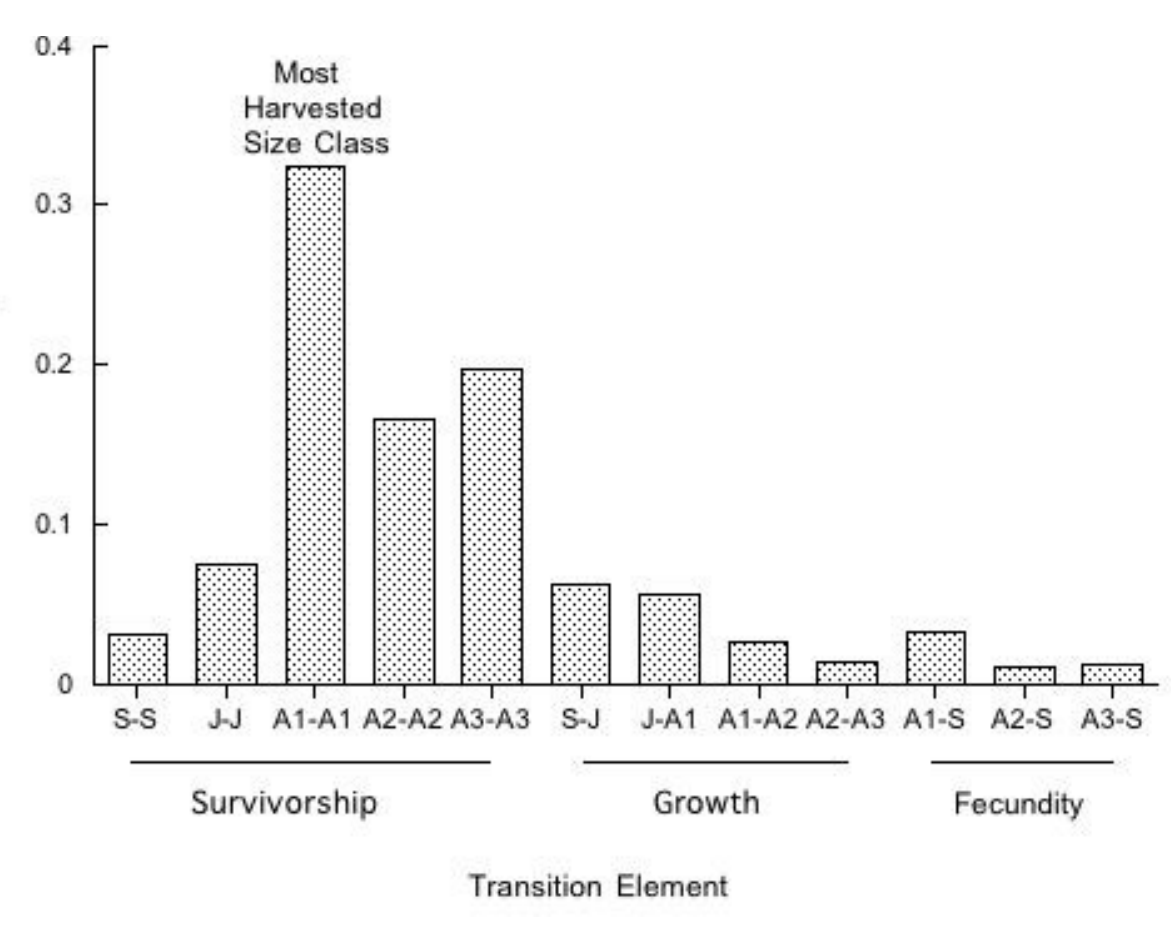
Fig. 4. Elasticity values for transition elements, or the relative contribution of each transition element to l , the finite population growth rate at stability. Because the elasticities of l to all of the elements in a matrix sum to 100%, the elasticity of l to a given element may be interpreted as the relative importance of that element to l . The transition elements are on the horizontal axis. The survivorship, growth, and fecundity elasticities are labeled. The stage classes are abbreviated as follows: S is for seedlings, J is for juvenile, and A1, A2, and A3 are for Adults 1, 2, 3, respectively. S-S means seedling survivorship and permanence in the seedling size class. S-J means seedling to juvenile transition. A1-S means the fecundity of the A1 size class. Values are the means of 2000 bootstrap